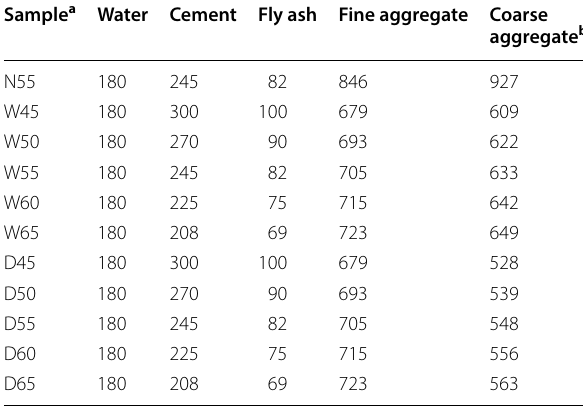
Table 2 Mix proportions of concrete